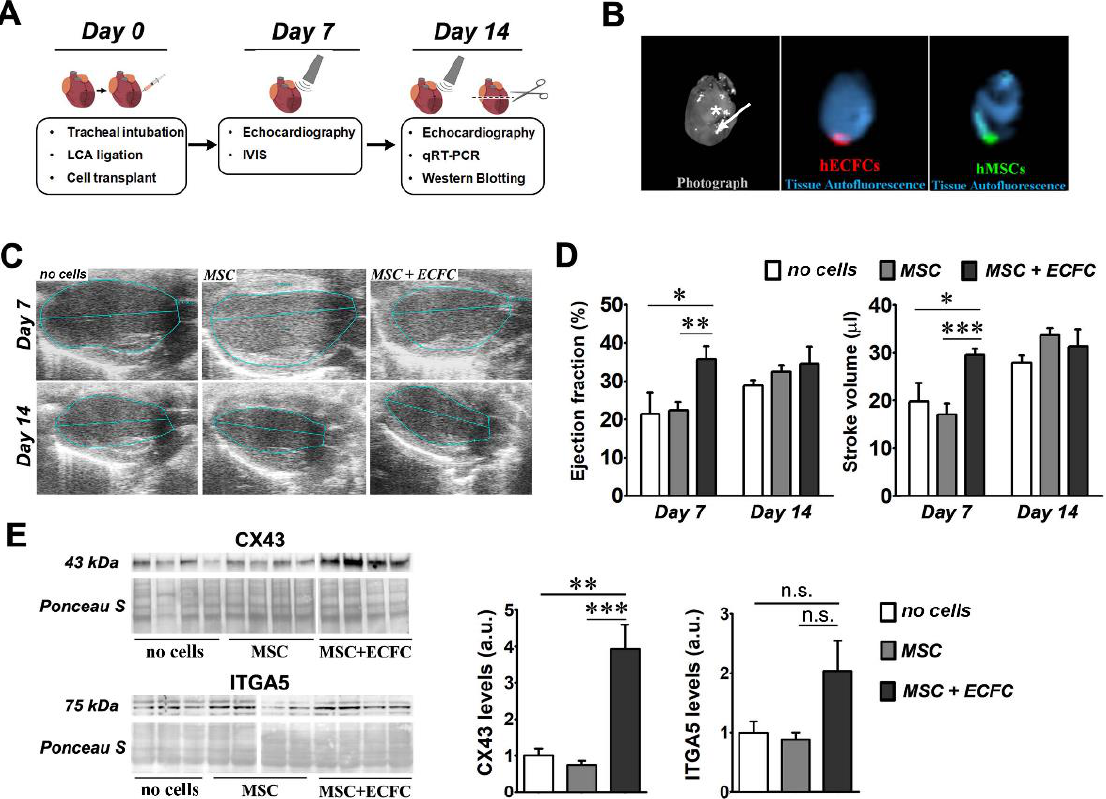
Figure 1. The effect of dual-cell therapy on infarcted myocardium. ( A ) Schematic representation of the experimental timeline; ( B ) ex vivo fluorescent imaging of a murine heart at 7 days after transplantation with CMFDA-labeled MSC and CMTPX -labeled ECFC at a cell ratio of 9:1 (MSC: ECFC). The white star indicates the ligature and the arrow shows the injection site and the direction of the infusion (towards the apex). Note the local retention of both MSC (green) and ECFC (red) at this time-point. ( C ) Representative echocardiography images obtained at 7 and 14 days after surgery in B-mode parasternal long axis; ( D ) ejection fraction and stroke volume determined at days 7 and 14 post-transplant. Data are mean ± SEM; ( E ) Western blot images showing the levels of CX43 and ITGA5 in the ventricular samples of infarcted mice with or without cell therapy at 14 days after surgery. The densitometry quantification relative to the no cells group is illustrated on the right side for both proteins. (Statistics: two-way and one-way ANOVA, followed by Tukey’s multiple comparison test; * p value < 0.05; ** p value < 0.01, *** p < 0.001).